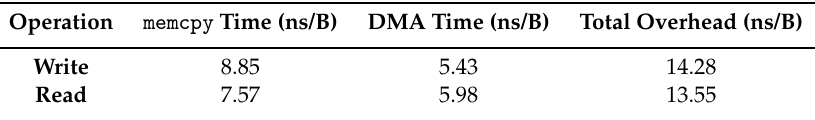
Table 5. Memory management